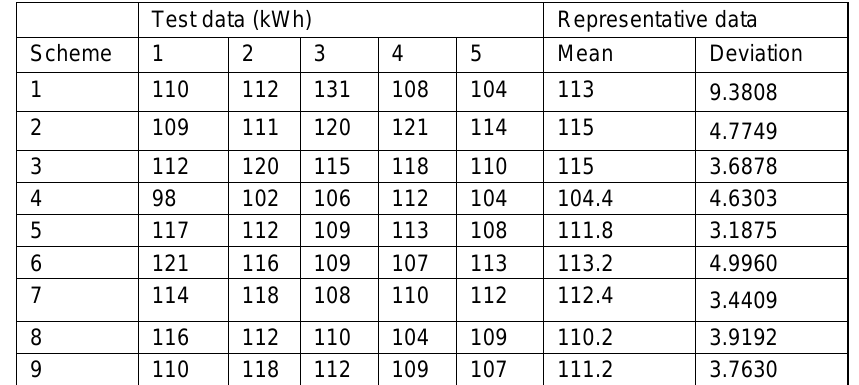
Table 2 – Test data of electric energy consumption from these